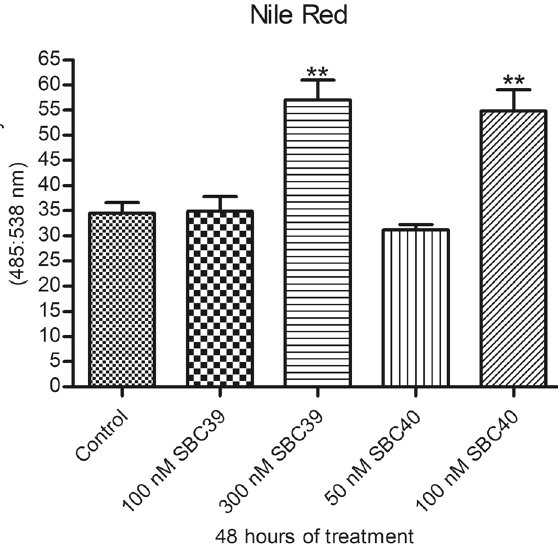
Figure 8. Analysis of Nile Red accumulation. Fluorometric analyses indicate a significant increase in Nile Red accumulation after treatment with 300 nM SBC 39 and 100 nM SBC40. Bars represent standard deviation. * p < 0.05, ** p < 0.01, and *** p <